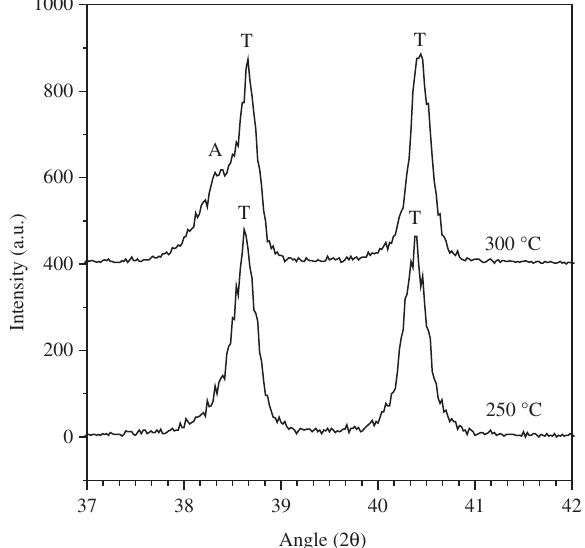
Figure 4. XRD patterns showing the crystallization of the passive film of titanium surfaces oxidized 48 hours in air (T = titanium, A =